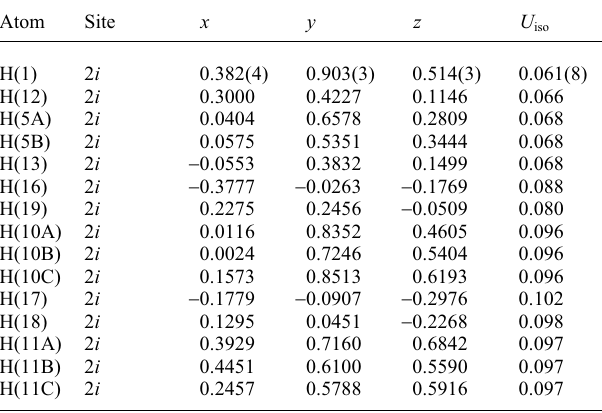
Table 2. Atomic coordinates and displacement parameters (in Å 2 )